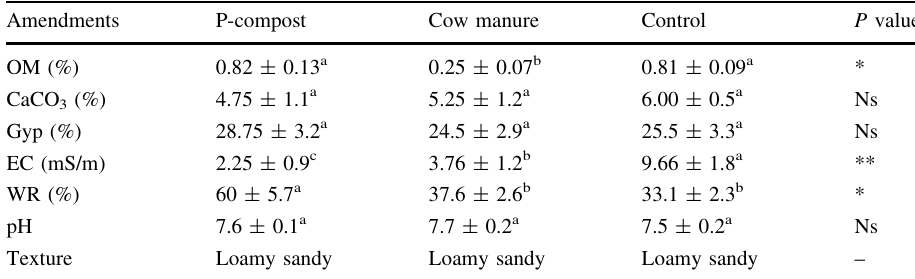
Table 2 Soil characteristics after 2 years of applying cow manure and